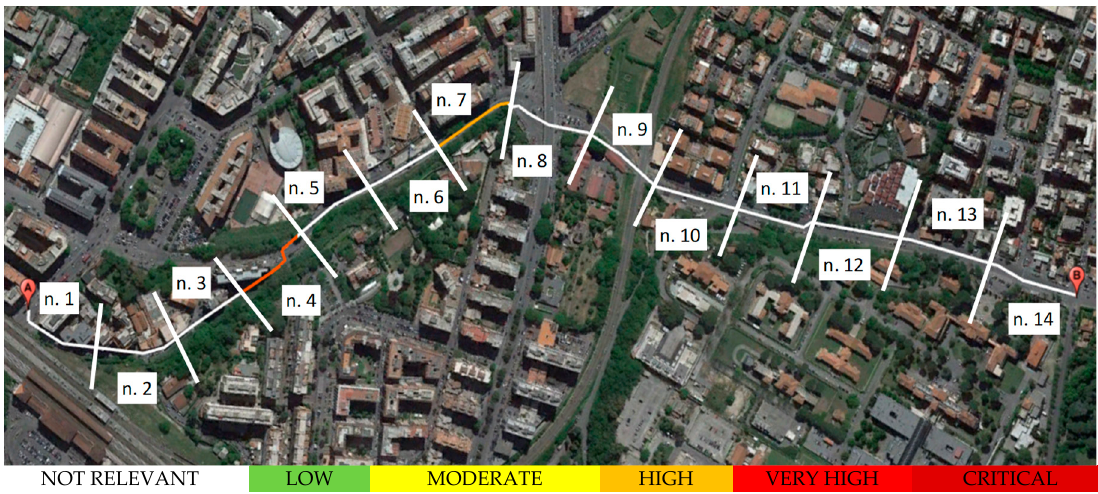
Figure 7. Map of risk of ROAD7.